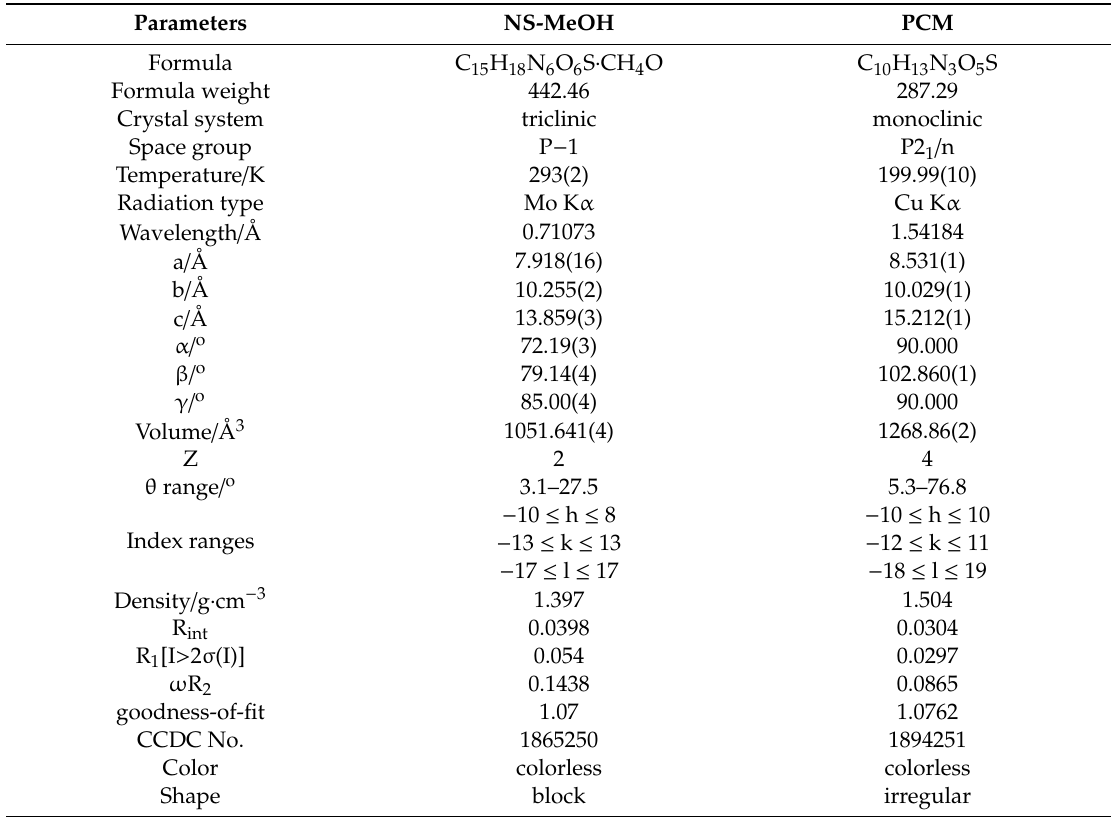
Table1. CrystallographicdataofNS-MeOHand[[3-[(Dimethylamino)carbonyl]-2-pyridinyl]sulfonyl]carbamic acid methyl (PCM).